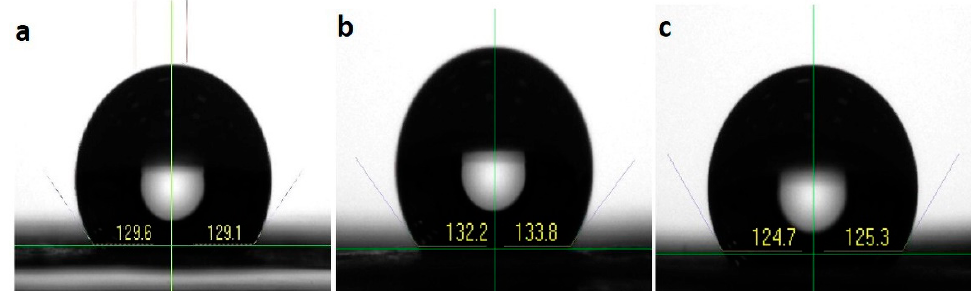
Figure 5. Representative photographs showing the water contact angle for ( a ) PCL, ( b ) PCLHA, and ( c ) PCLMTA membranes.